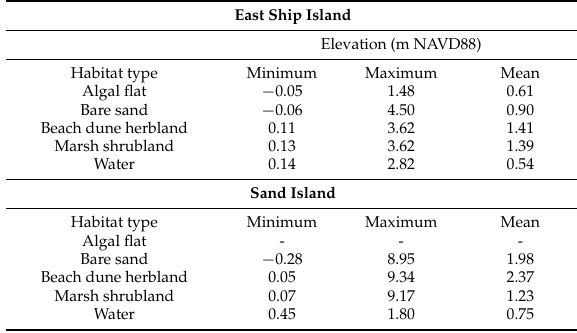
Table 5. Minimum, maximum and mean elevations of habitat types on East Ship and